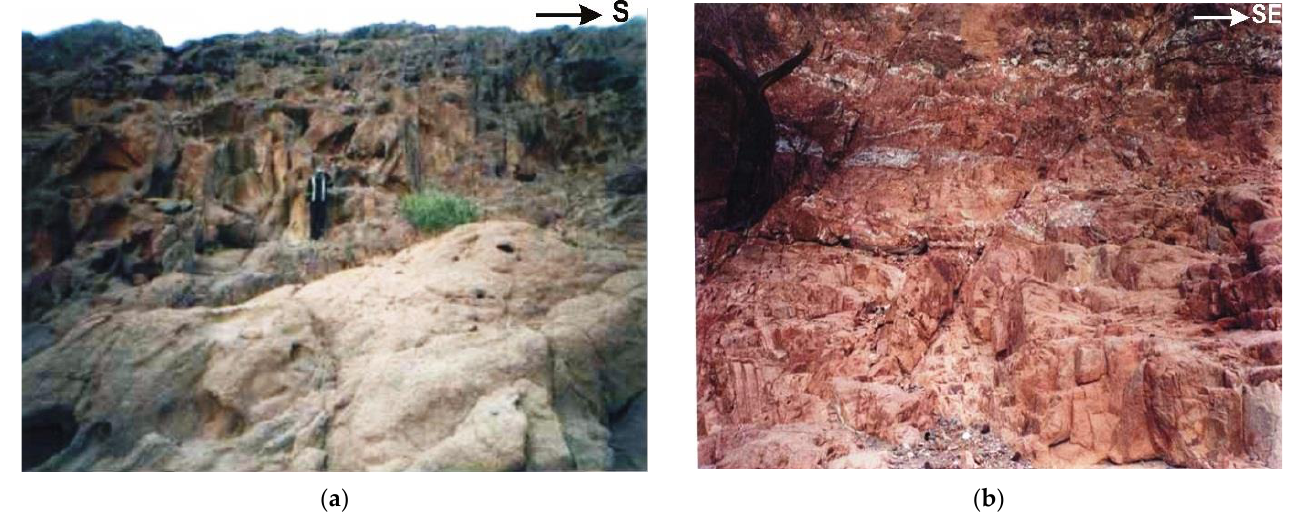
Figure 2. Field photographs reveal ( a ) cavernous weathering of syenogranite at W. Seih-Sidri; and ( b ) pegmatites at W. Sidri, southwestern Sinai, Egypt.